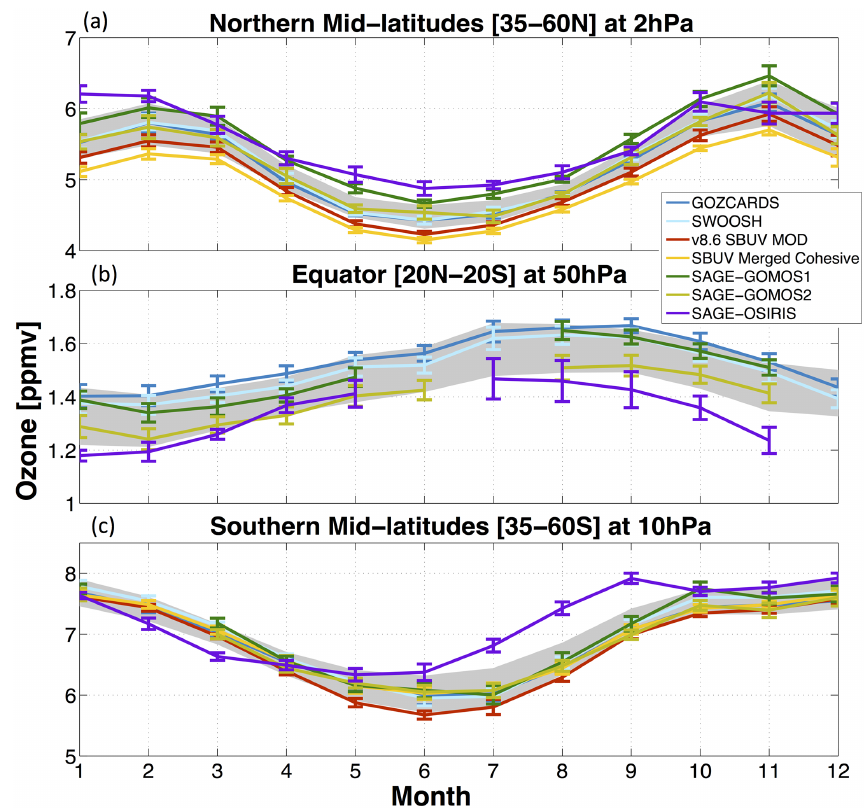
Figure 3. Annual cycle averaged over the 1984–2011 period for (a) the Northern Hemisphere mid-latitudes (35–60 ◦ N) at 2hPa, (b) the tropics (20 ◦ N–20 ◦ S) at 50hPa, and (c) the Southern Hemisphere mid-latitudes (35–60 ◦ S) at 10hPa. Error bars indicate ± 2 standard errors of the mean, while the grey range shows ± 1 standard deviation (mean of all data sets). Values (monthly values, standard deviation, and standard error) are shown only if data are available for more than half (14) of the 28 years in the time